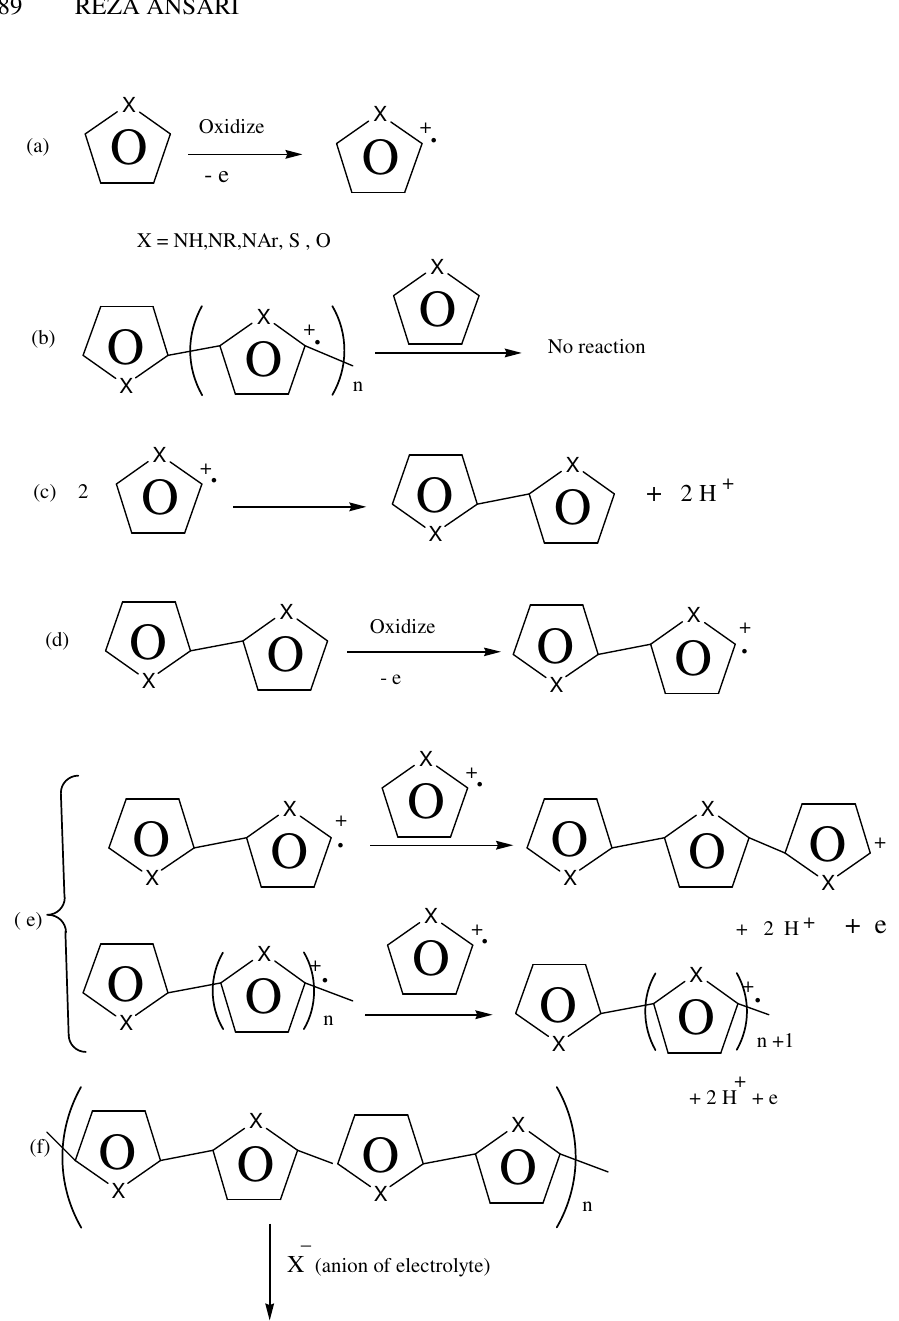
Figure 2. The accepted mechanism for electropolymerisation mechanism of polypyrrole or other aromatic heterocyclic